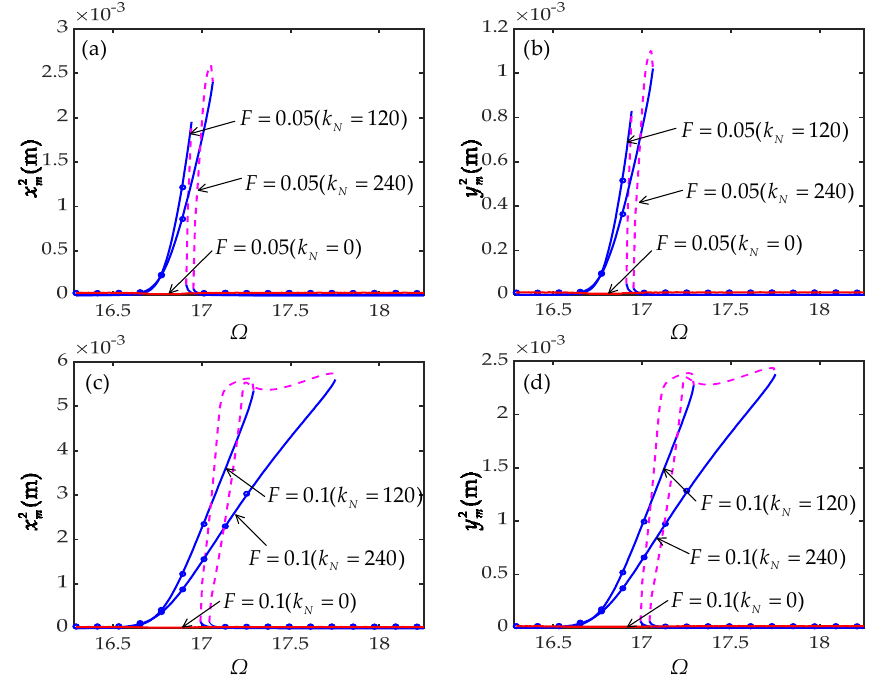
Figure 7. Frequency response curves for the second mode at Ω = ω 1 + εσ 2 and σ 1 = 0.01: ( a ): horizontal displacement for F = 0.05, ( b ): vertical displacement for F = 0.05, ( c ): horizontal displacement for F = 0.1, ( d ): vertical displacement for F = 0.1.